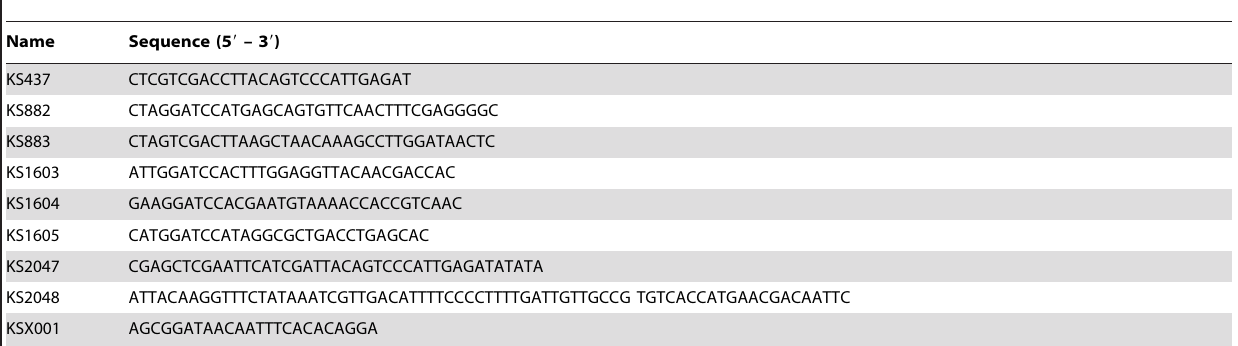
Table 2. List of oligonucleotides used in this